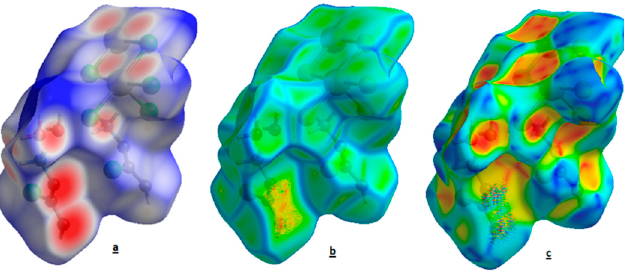
Figure 7. The HS mapped with d norm ( a ). Shape index ( b ) and curvedness ( c ) for the title compound.